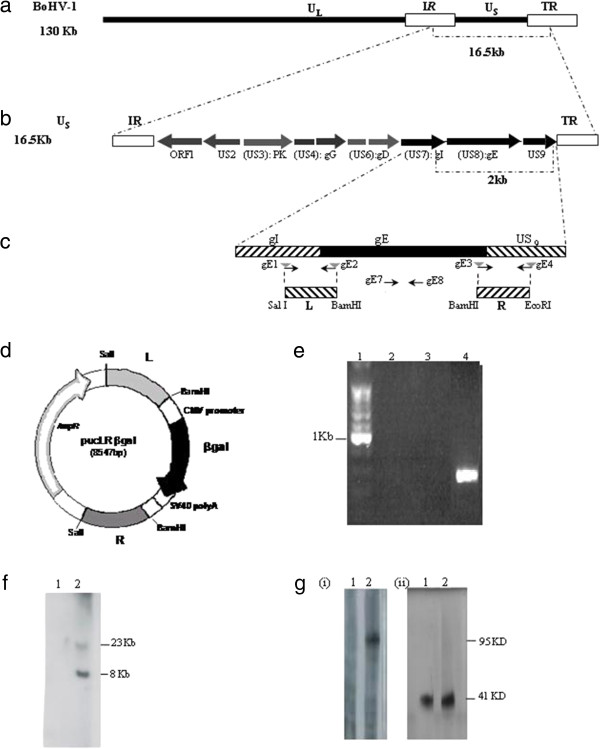
Molecular structure of BoHV-1ΔgEβgal virus. (a) Target region for the gE deletion in BoHV-1 genome. (b) gE ORF (US8) is flanked by gI (US7) and US9 genes. (c) Primers gE1 and gE2 were designed to amplify the left (L) fragment, and primers gE3 and gE4 were designed to amplify the right (R) fragment. The sequences of primers gE2, gE3 and gE4 were designed in order to create the depicted restriction sites to facilitate the cloning strategy. (d) pUCLRβgal recombination vector diagram restriction sites used for cloning and relative position of the elements decribed are shown (e) Confirmation gE-specific deletion by PCR. Lanes 2–4 primers specific to the gE sequence (gE7 and gE8) were used. Different templates were used for each lane shown: Lane 2 negative control (ultrapure sterile water); lane 3 BoHV-1ΔgEβgal DNA; lane 4 parental BoHV-1 LA DNA; lanes 1 molecular weight marker (100pb, Promega). (f) Molecular characterization of the recombinant BoHV-1ΔgEβgal strain. Southern blot analysis for gE gene. Viral DNA from BoHV-1ΔgEβgal (lane 1) and from parental BoHV-1 LA strain (lane 2) were digested with HindIII restriction enzyme, separated by 0.6% agarose gel electrophoresis, blotted to a membrane and probed with the gE probe. (g) Western blot for gE protein. Concentrated virus (BoHV-1ΔgEβgal, lane 1; and parental BoHV-1 LA, lane 2) was separated by electrophoresis in a 12% SDS-PAGE, blotted to a membrane and incubated with specific serum. Panel (i) gE-specific monoclonal antibody, panel (ii) gD-specific monoclonal antibody.